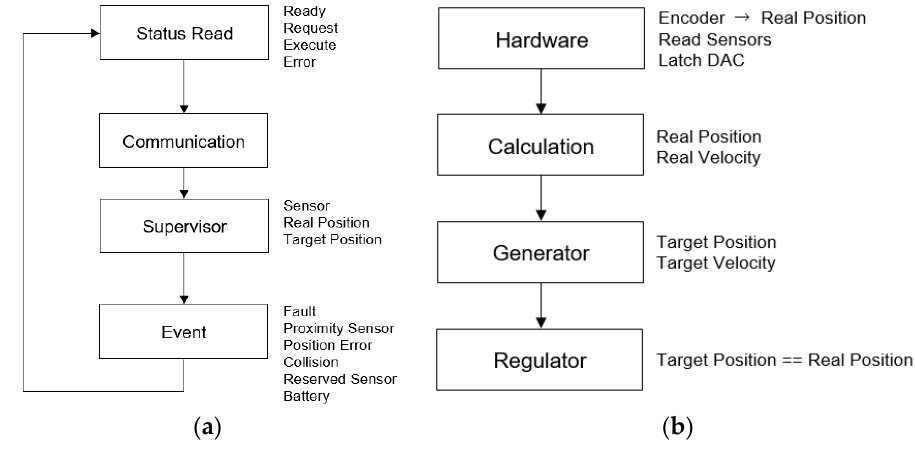
Figure 9. Flowchart in firmware: ( a ) background mode, and ( b ) interrupt mode.